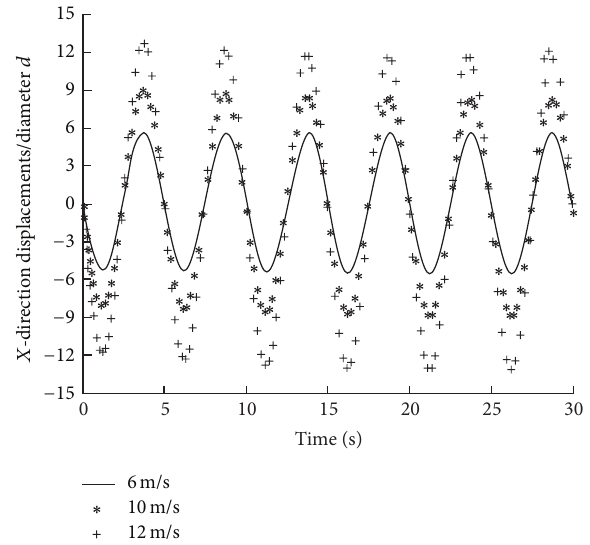
Figure 7: 𝑋 -components displacements of the leeward conductor at the point of middle subspan.